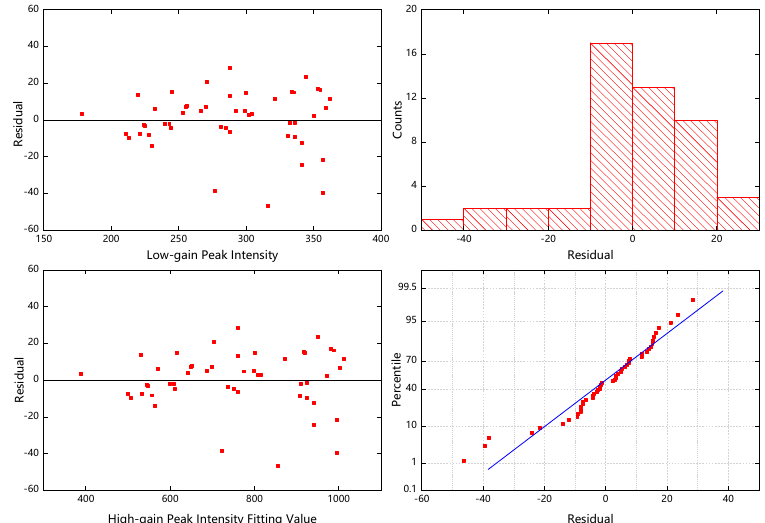
14 of 17 Figure 15. Residual plots of the fitted high- and low-gain peak intensity regression model, which are composed of the residual plot with the independent variable as abscissa ( upper left ), the residual plot with the fitted value of the dependent variable as abscissa ( lower left ), the histogram of the residuals ( upper right ), and the normal probability plot of the residuals ( lower right ). The units of coordinate axes are arbitrary.